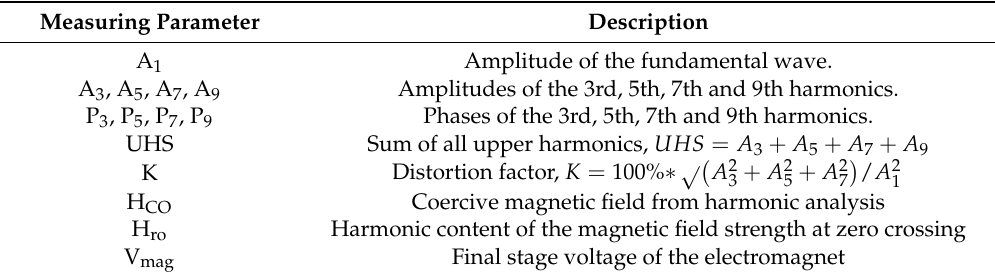
Table 1. Measuring parameters from Harmonic Analysis (HA).